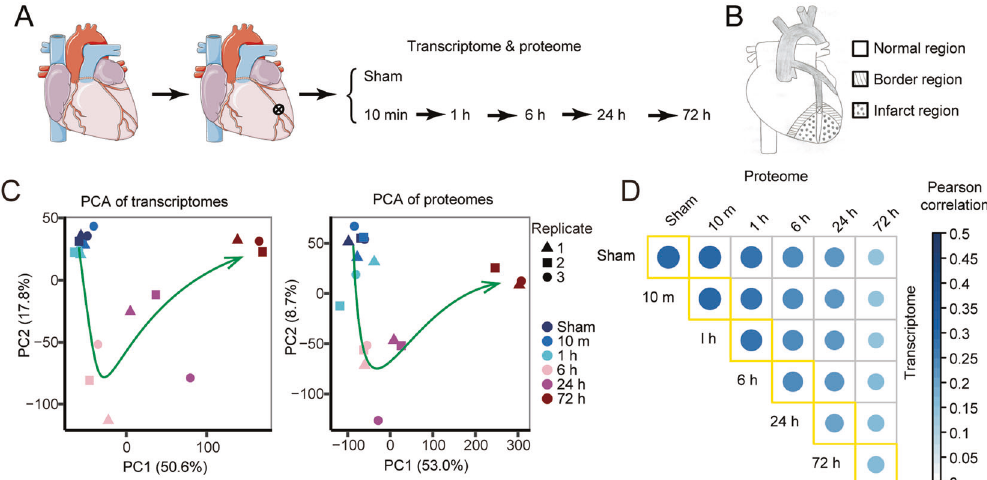
Fig. 1 Transcriptome and proteome pro fi ling of AMI model. A Schematic diagram of AMI model and the stages for transcriptome and proteome pro fi ling. Eighteen mice were randomly divided into six groups. AMI was established by ligation of the proximal left anterior descending coronary artery indicated by the circled “ x ” . B Schematic diagram shows the infarct region indicated by dotted area. C Principal component analysis (PCA) of the transcriptome (left) and the proteome (right). Arrowed lines indicate the trajectory of AMI progress. D The correlation between the transcriptome and proteome pro fi